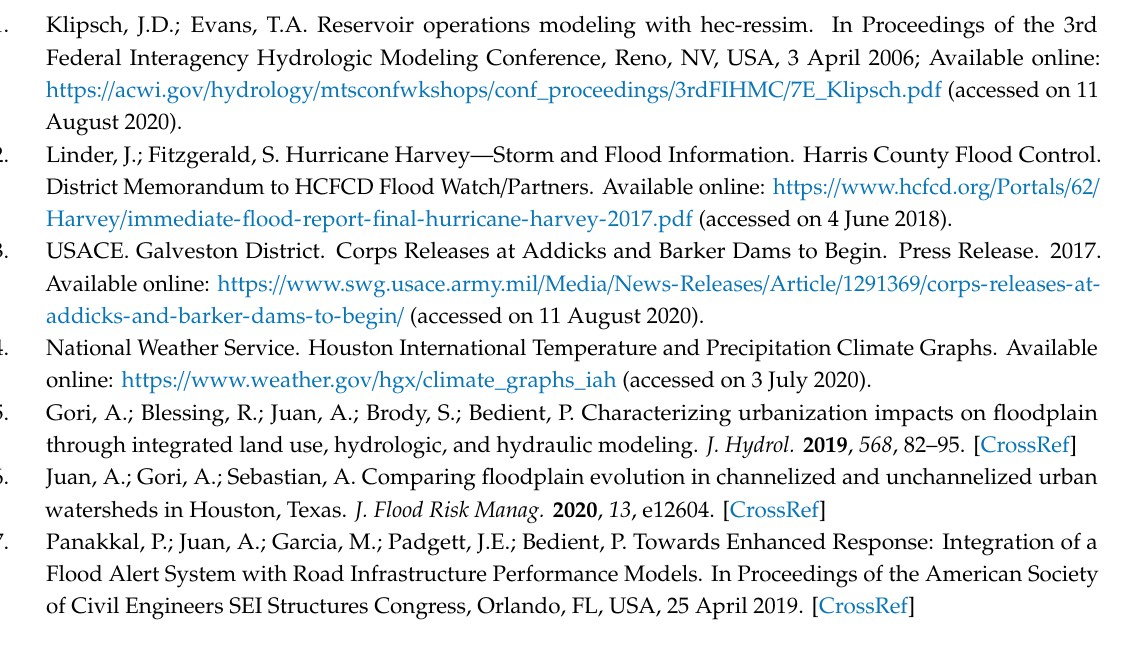
Section S.1: HEC-RAS 2D Sluice Gate Operation Scripts , Figure S1: Rule operation code for Addicks reservoir sluice gate, Section S.2: Full Coded Script of Addicks Reservoir Gate Copied from the HEC-RAS Interface . Author Contributions: M.G. student, led the modeling, hypothesis testing, and writing. A.J., research